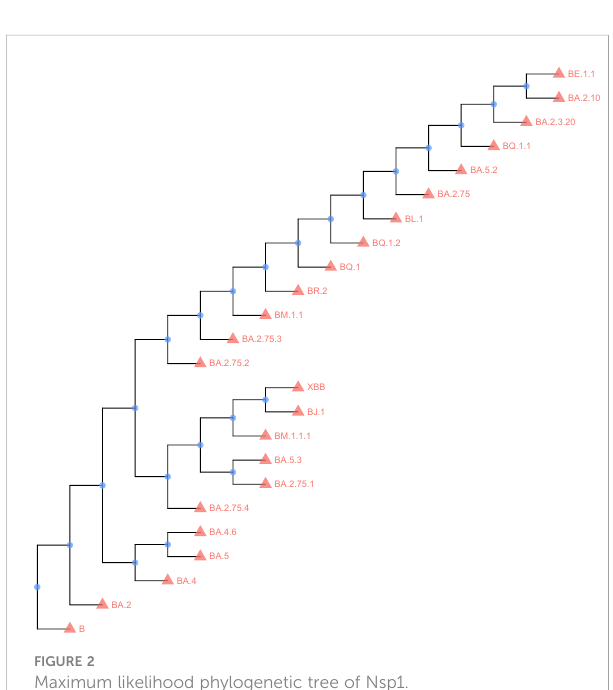
FIGURE 2 Maximum likelihood phylogenetic tree of Nsp1.